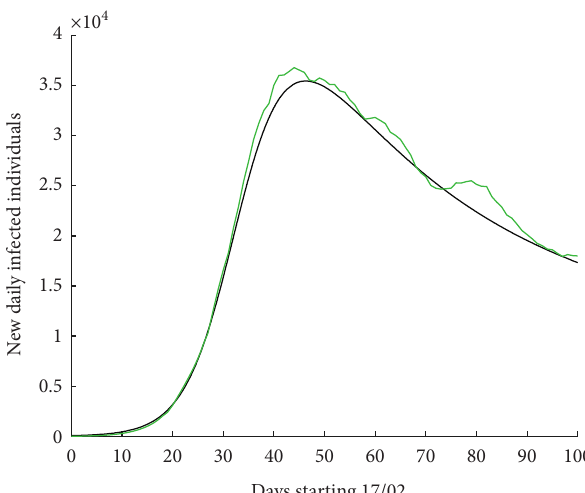
Figure 5: Number of new daily infected individuals in Europe, starting 17 February 2020 for 100 days. Real data are shown in green colour, while the result of the numerical simulations using fractional differential equations is shown in black colour.